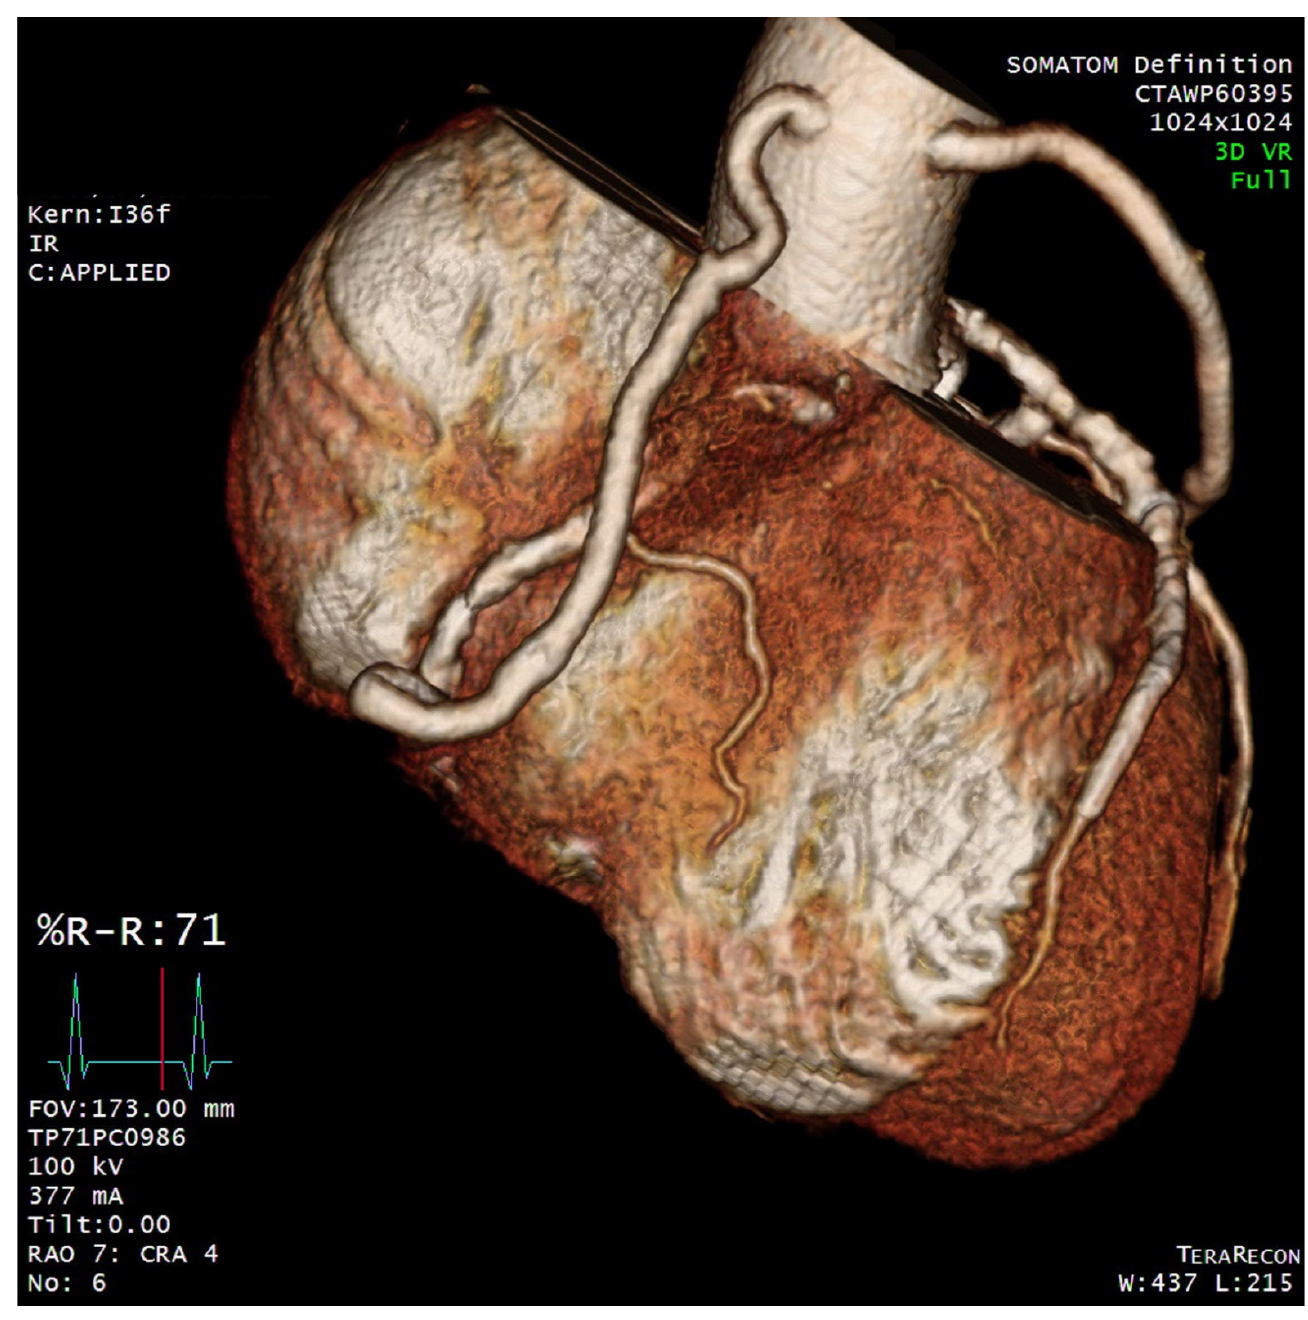
Figure 2. Postoperative Computed Tomography Finding. Computed tomography revealed that the bypass grafts were patent without contrast fill in the aneurysmal portion of the right coronary artery.